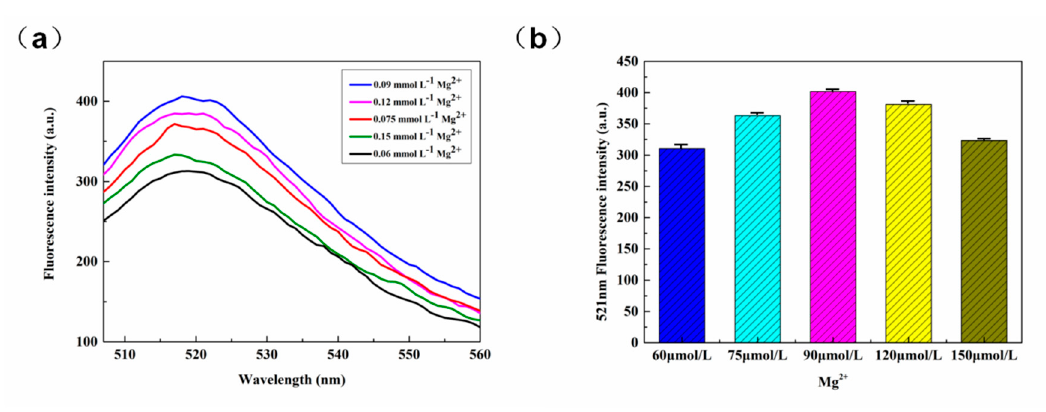
Figure 7. ( a ) Fluorescence spectra for various concentrations of Mg 2 + . ( b ) Fluorescence intensity (521 nm) as a function of Mg 2 + concentration.